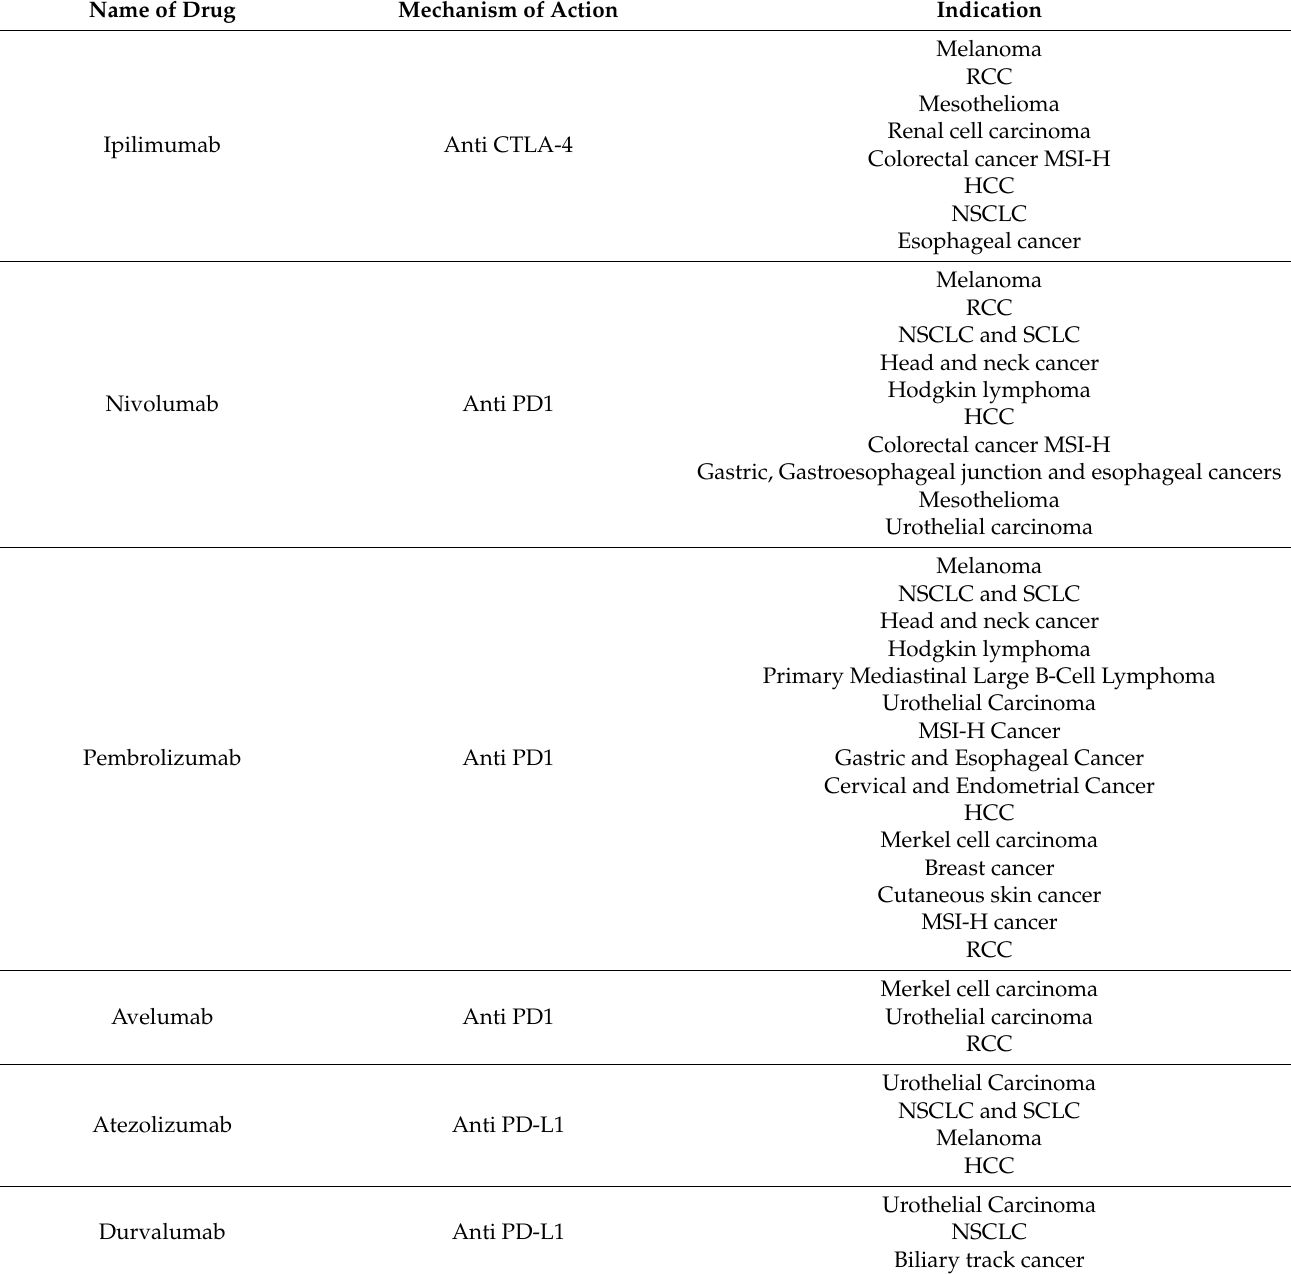
Table 1. Indications and mechanism of action